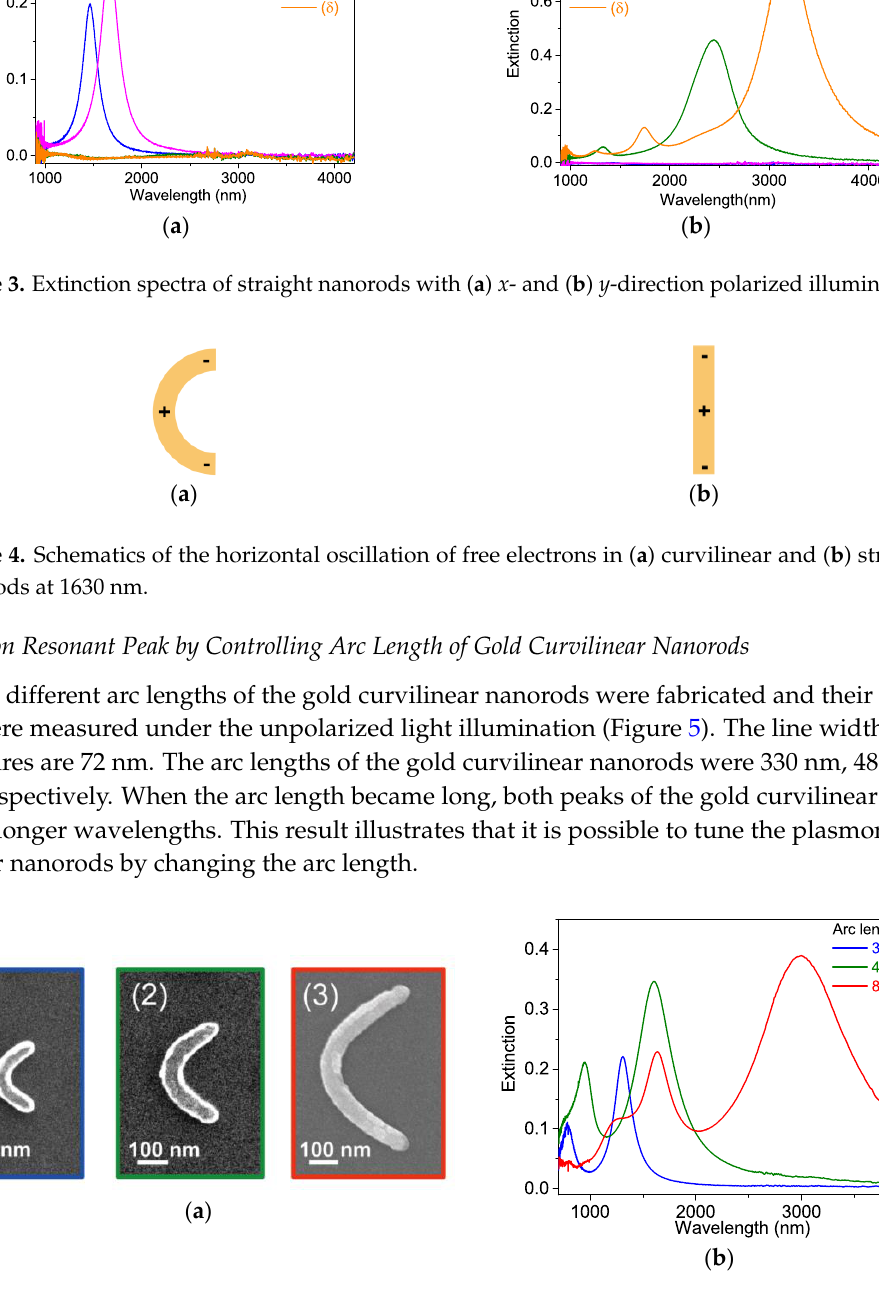
Figure 5. ( a ) SEM images of the fabricated curvilinear nanorods. ( b ) Extinction spectra of three different arc lengths of gold curvilinear nanorods.